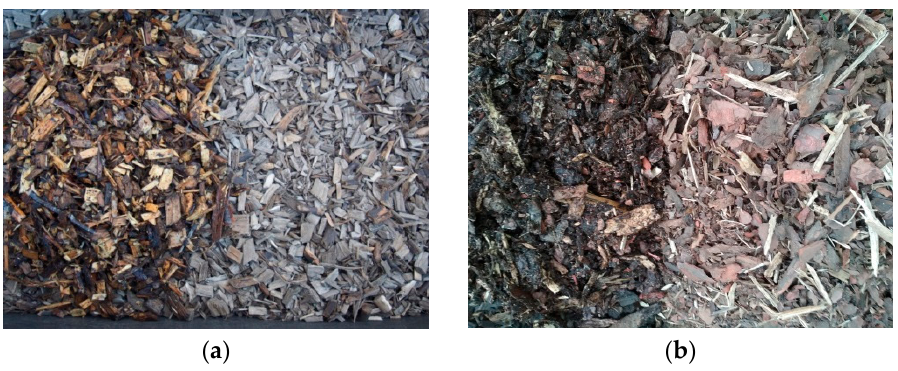
Figure 2. Tested materials— (a) Green wood chips; (b) Wet bark.